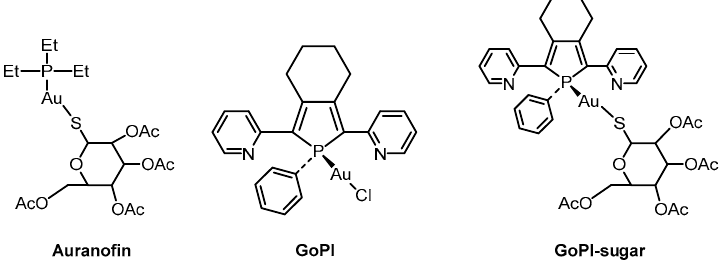
Figure 1. Structure of gold(I)-based complexes as inhibitors of human glutathione reductase, thioredoxin reductase and Schistosoma mansoni thioredoxin-glutathione reductase.